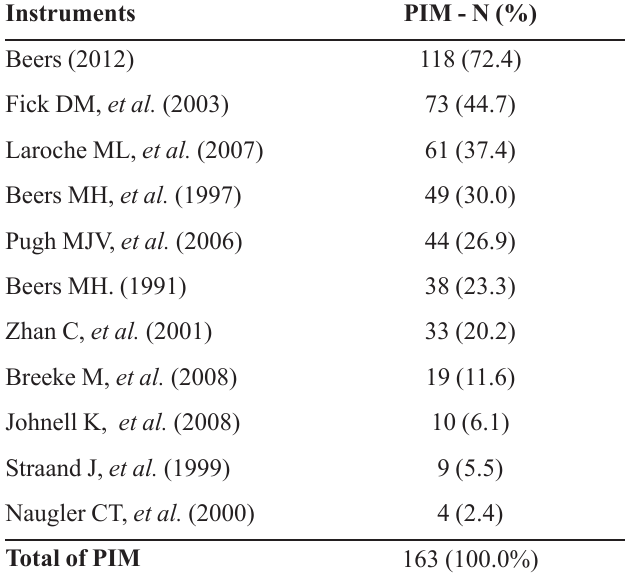
TABLE II - Frequency of drugs considered potentially inappropriate medications (PIM) for elderly people, according to the instruments identified in Paho, Lilacs and Pubmed databases in February and March 2010, whose use should be